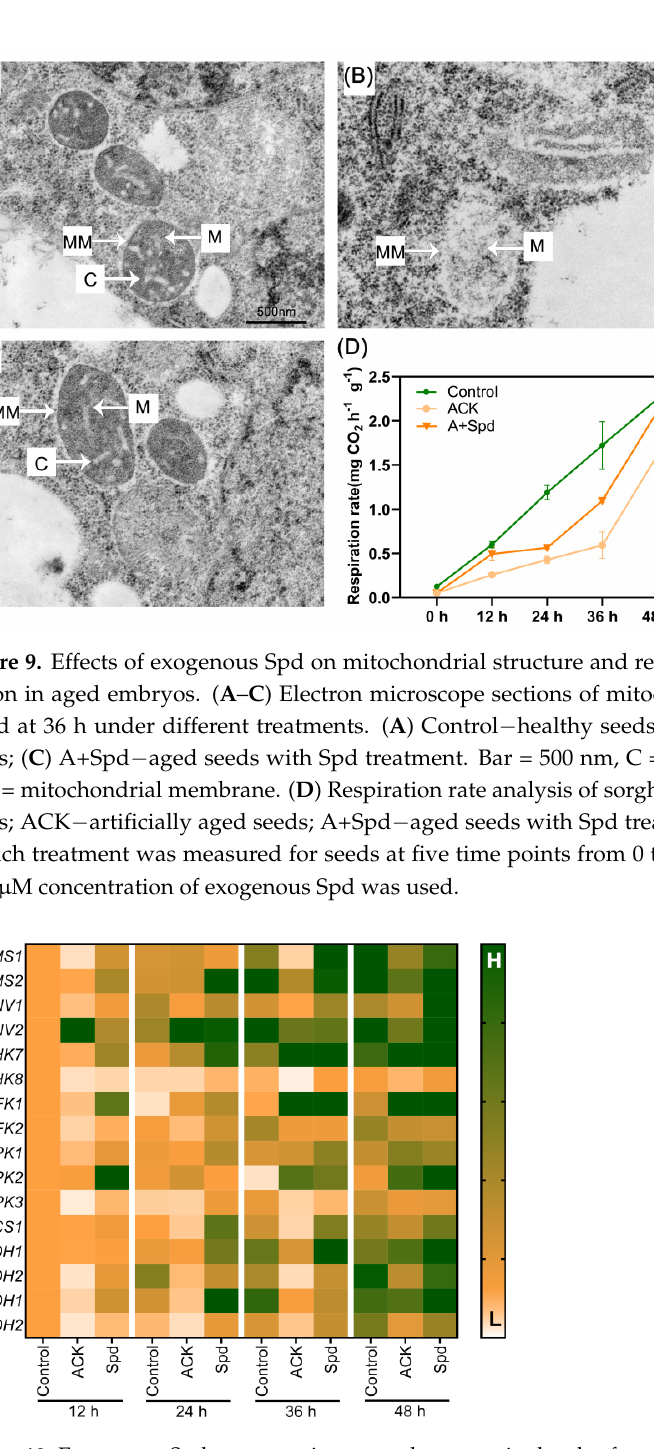
9 of 16 Figure 8. Effects of exogenous Spd on ATP content of aged seeds during germination. Con- trol − healthy seeds; ACK − artificially aged seeds; A+Spd − aged seeds with Spd treatment. A total of five time points from 0 to 48 h after germination were performed for each treatment. Different lowercase letters above the bars indicate significant levels of difference among the three treat- ments ( p < 0.05, Lsd). A 0.05 μ M concentration of exogenous Spd was used. 2.5. Improvement and Enhancement of Mitochondria and Respiration Rate in Germinating Arti- ficially Aged Seeds by Spd The mitochondrial membranes in the artificially aged embryos were blurred and